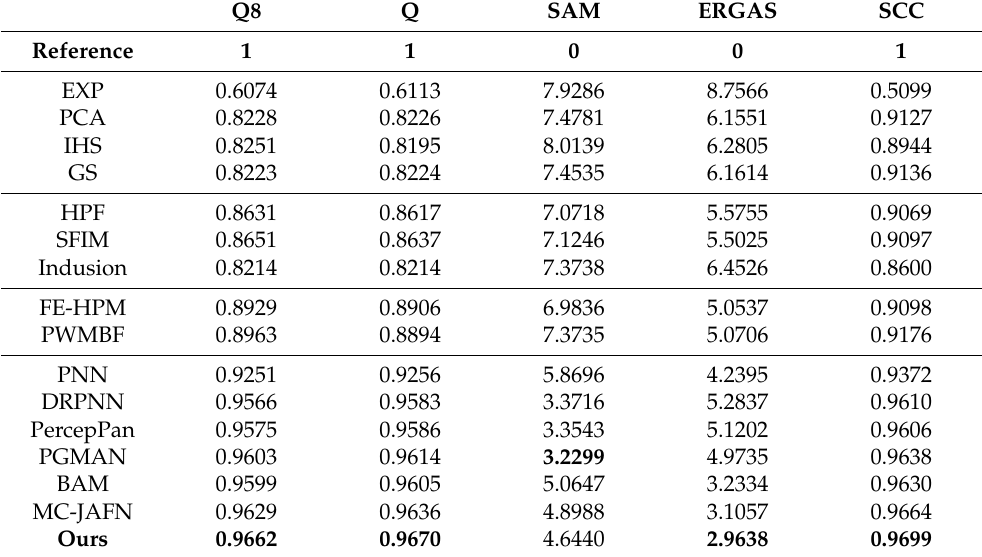
Table 3. Quantitative Evaluation for Reduced WorldView-2 Dataset. The Best Results are Shown in Bold